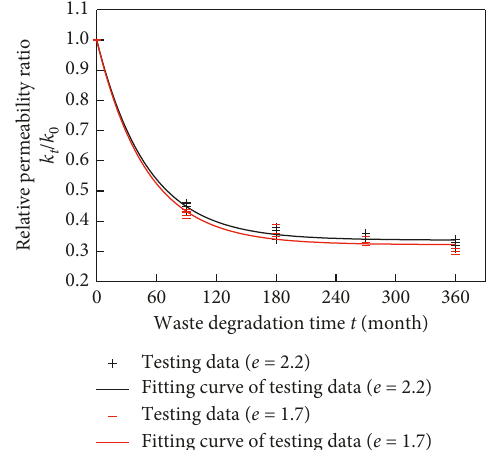
Figure 3: Saturated hydraulic conductivity distribution of MSW in the temporal domain [21].